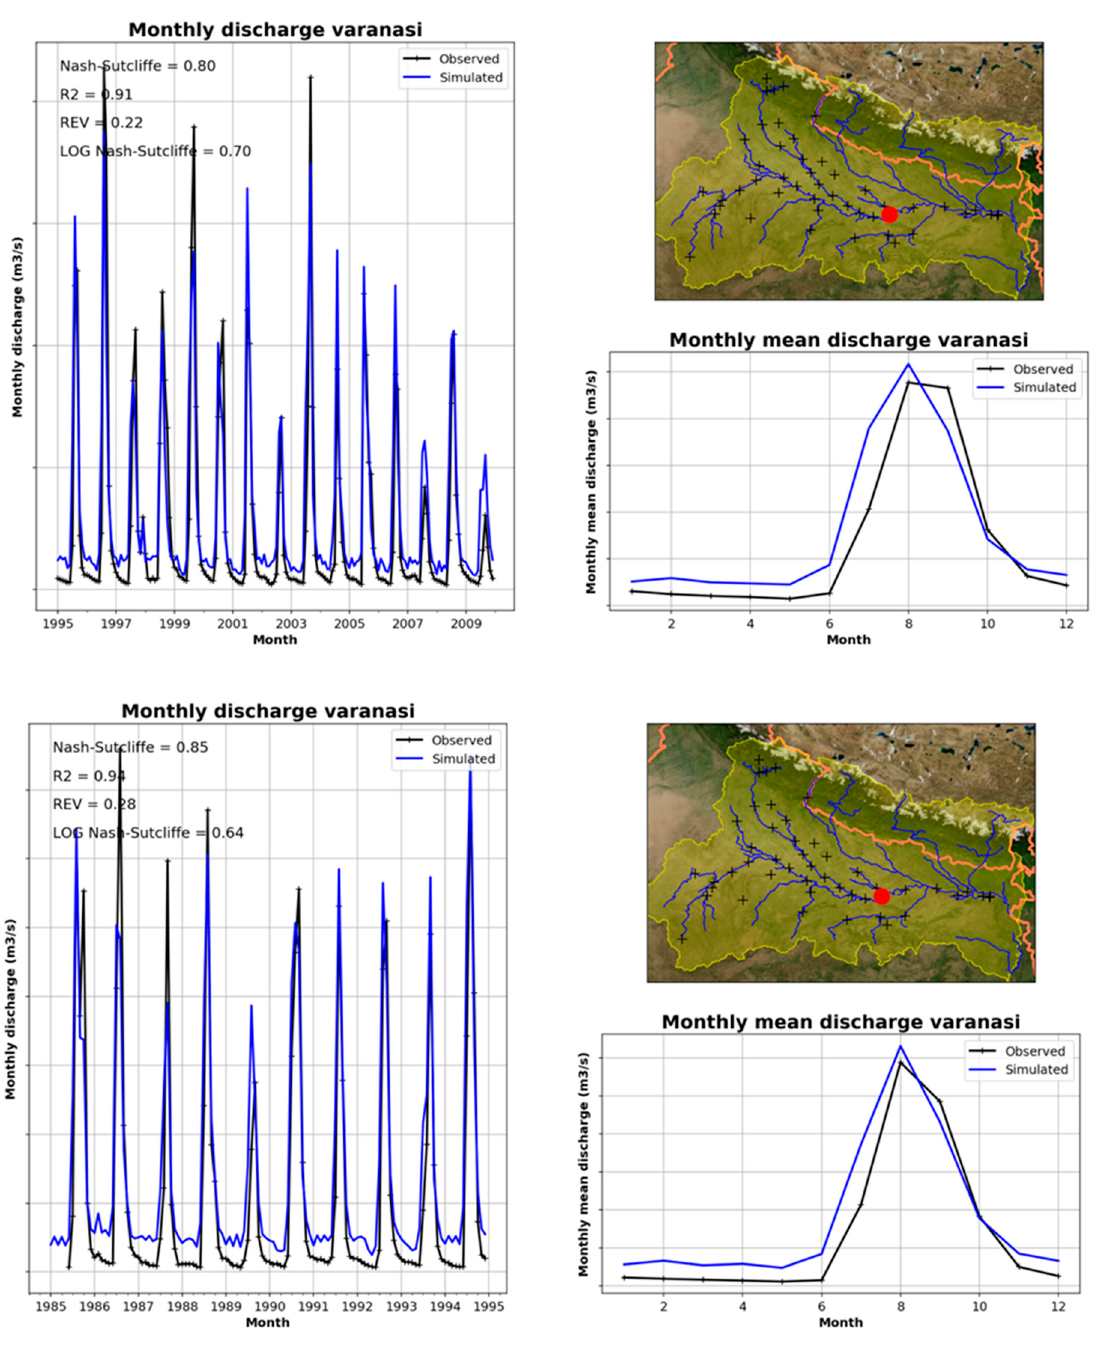
Figure 8. Validation (1985–1994, top ) and calibration (1995–2009, bottom ) results for the Ganga River at Varanasi; monthly discharges ( left ), mean monthly discharges ( right bottom ) and location of the station (red dot on map right top).